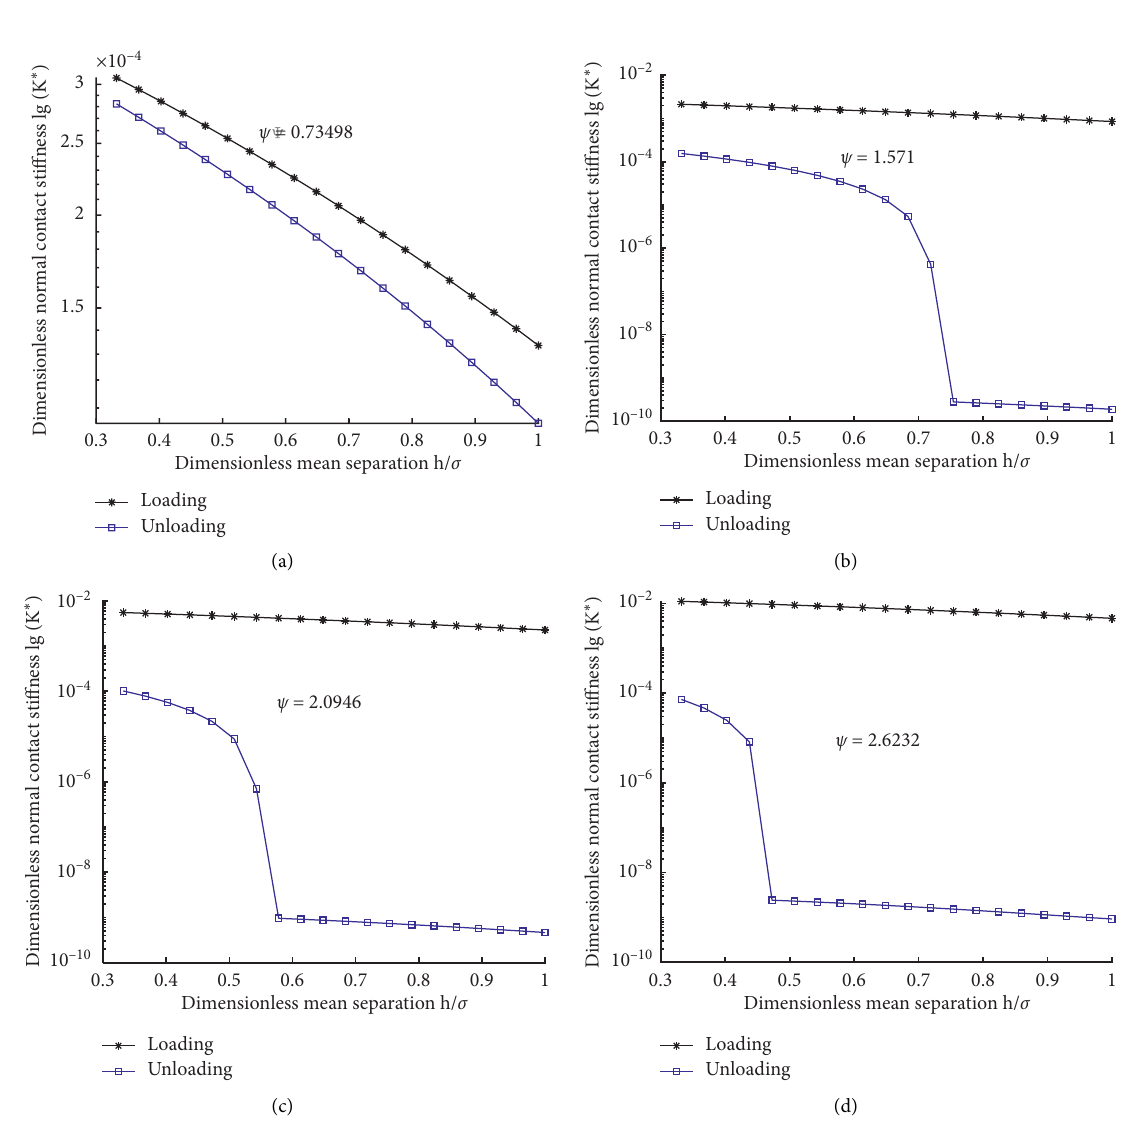
Figure 4: Influence of h ∗ on lg ( K ∗ ) . (a) ψ � 0 . 73498. (b) ψ � 1 . 571. (c) ψ � 2 . 0946. (d) ψ � 2 .